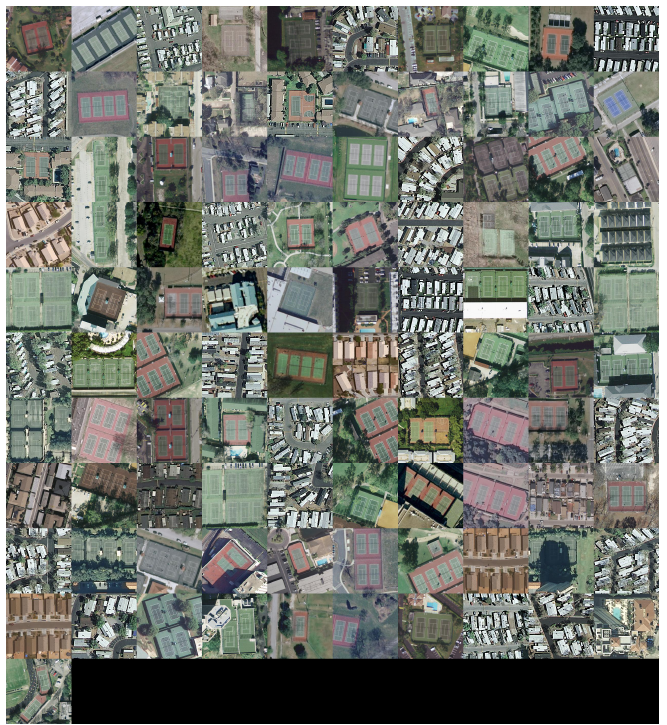
Figure 5. The remote sensing images of tennis courts clustered by the clustering-based method [30]. There are 101 images in total, and 71 images contain a tennis